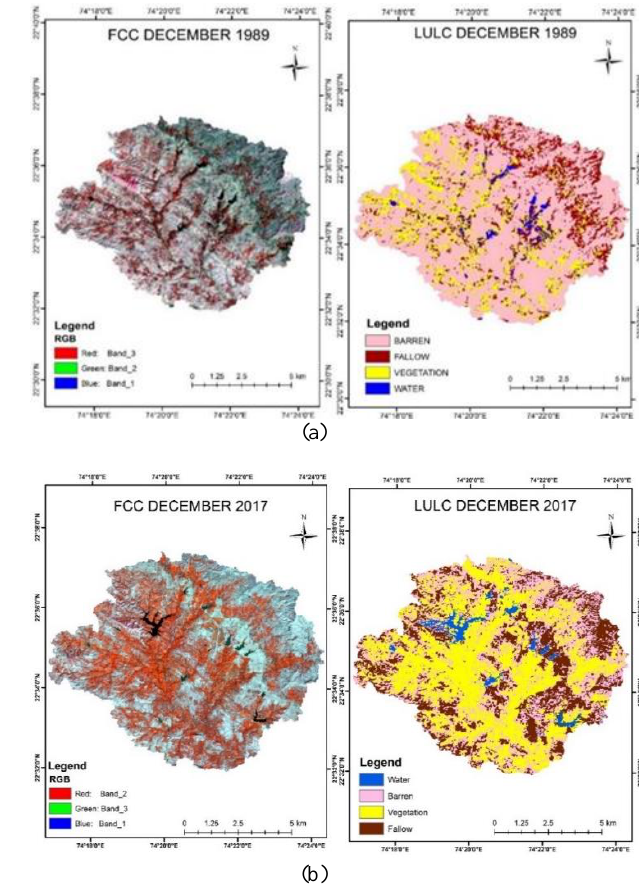
Figure 12 Maps showing FCC and LULC (a) 1989 and